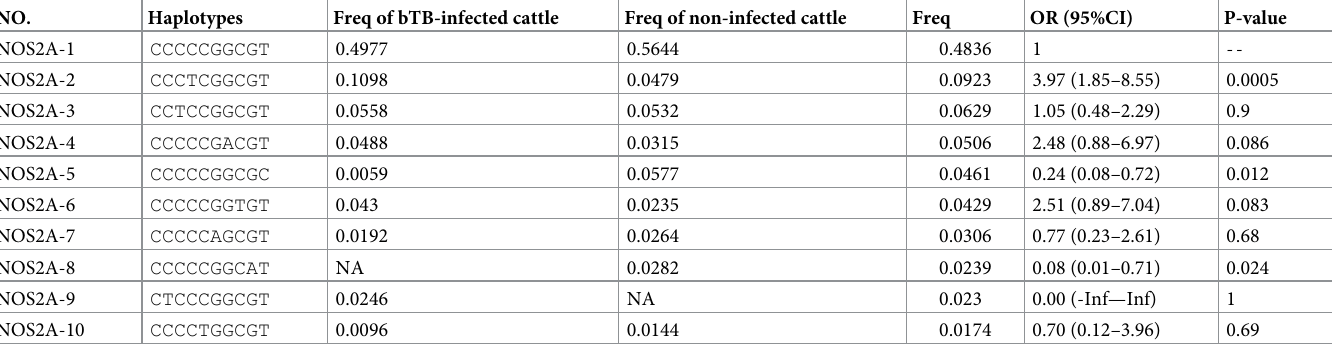
Table 5. Association analysis between NOS2A haplotypes and bTB